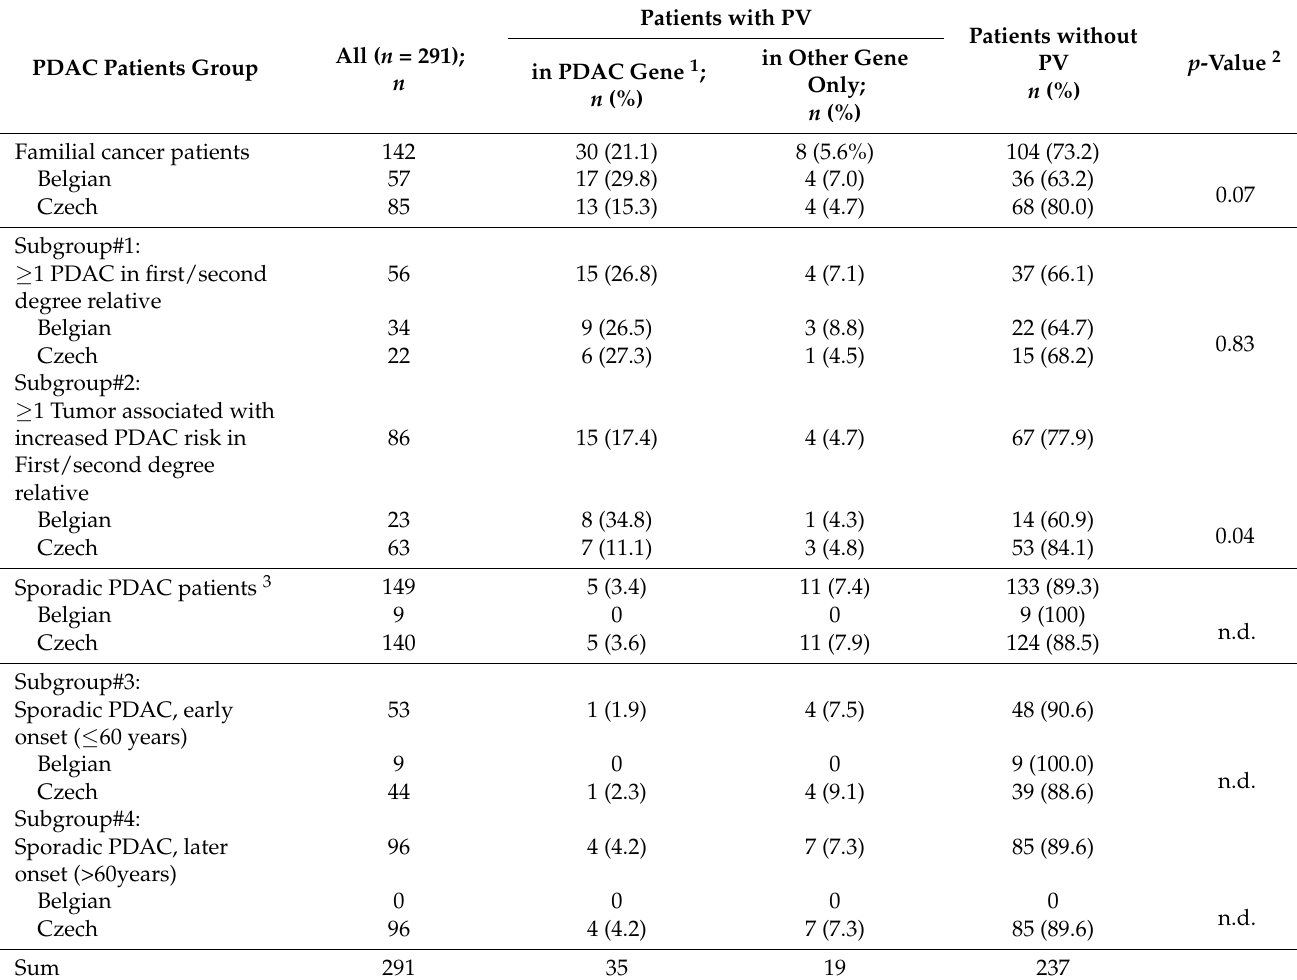
Table 3. Prevalence of PV in four subgroups ascertaining 291 patients with known family cancer history.